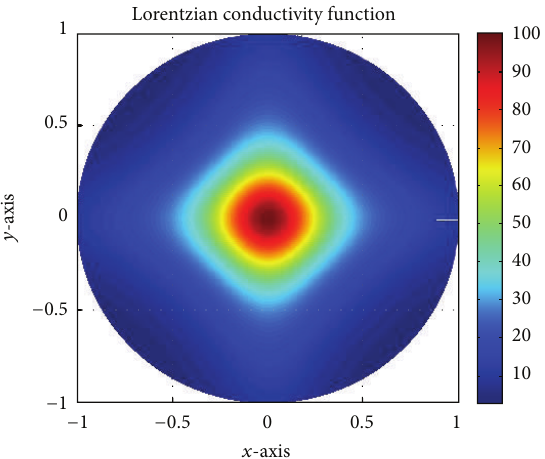
Figure 2: Example of a separable-variables Lorentzian conductivity −1 ⋅ (𝑦 2 + 0.1) −1 function 𝜎 = (𝑥 2 + 0.1)